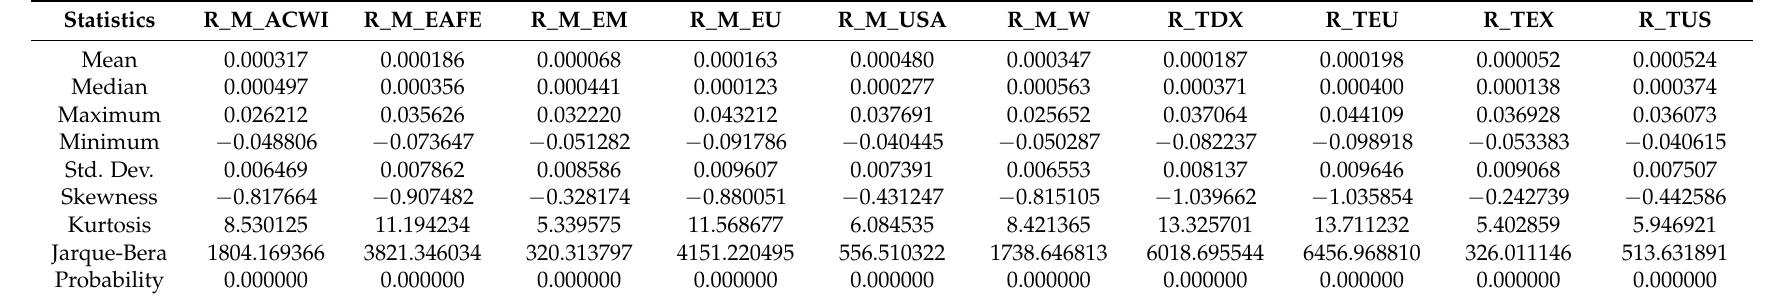
Table 1. Descriptive statistics of the sustainable and conventional